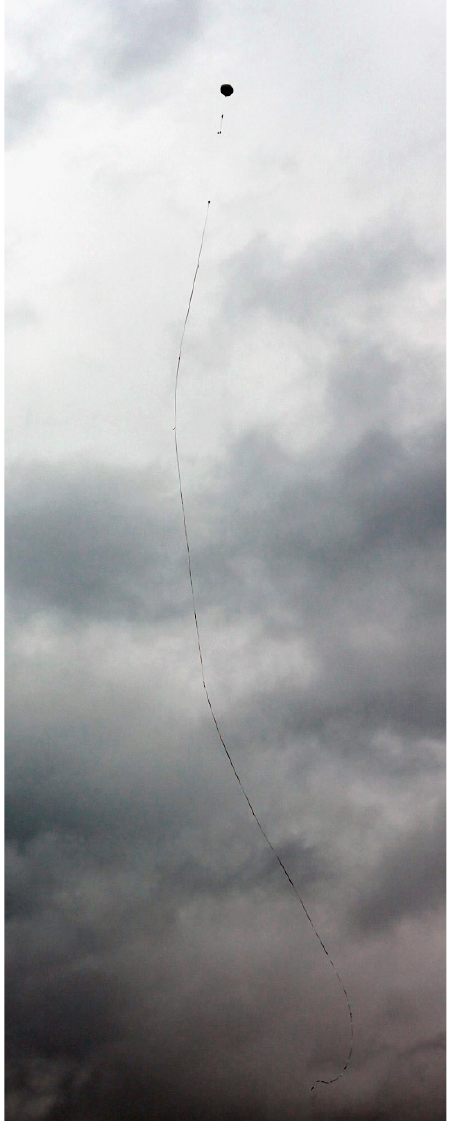
Figure 1. An example of a stratospheric balloon antenna—200 m-long VED launched by Warsaw University of Technology, 18 April 2015. University of Technology, 18 April